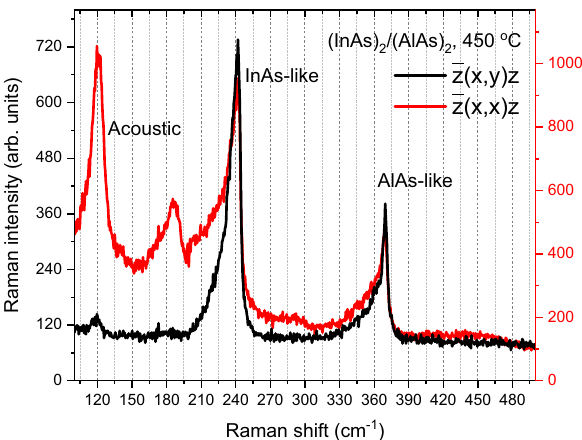
Figure 1. Raman spectra of (InAs) 2 /(AlAs) 2 grown at 450 °C under different polarization configurations. The labels ‘acoustic’, ‘InAs-like’ and ‘AlAs-like’ indicates the respective phonon